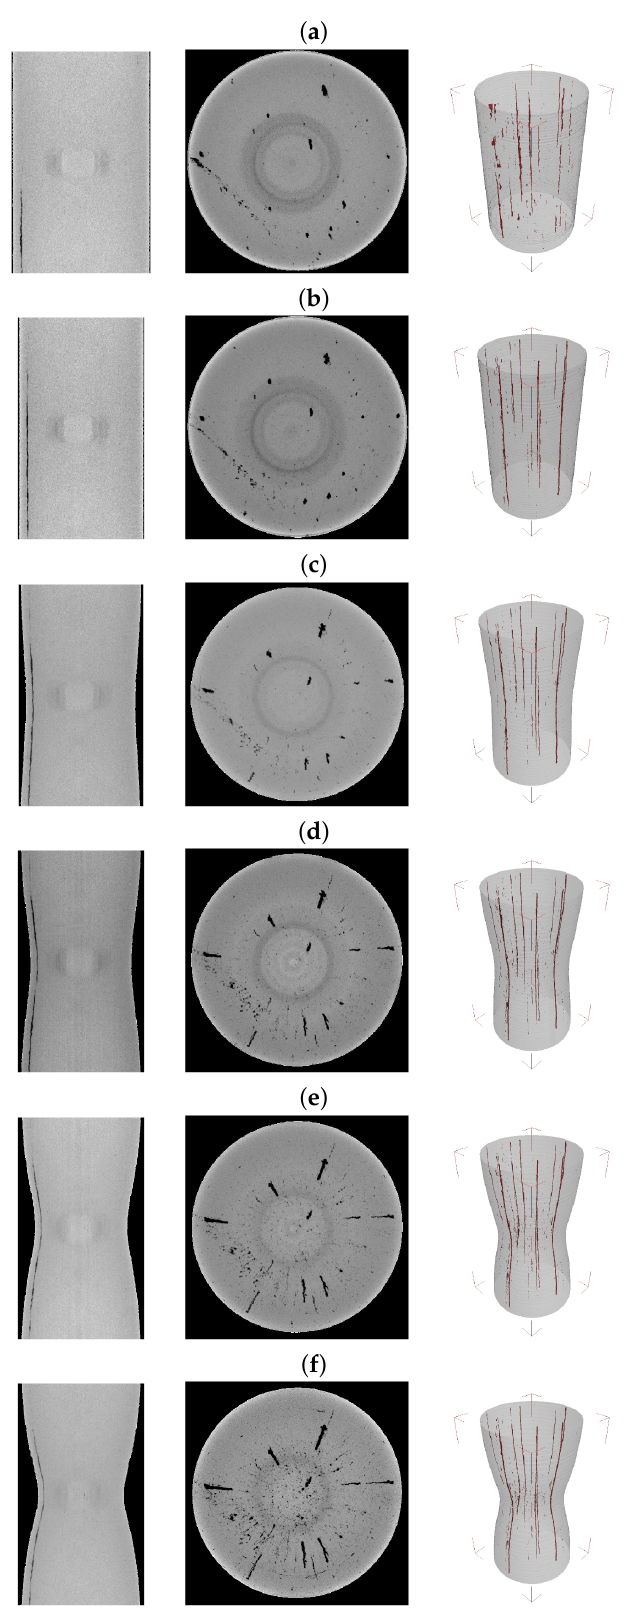
Figure 10. Results of the XRCT analysis of the necking zone for Material 2. For each step, three results are given: (I) Longitudinal section, (II) Damage projected on the cross section and (III) Perspective of the internal damage. ( a ) Step 0: Before testing ( ε eng = 0). ( b ) Step 1: Maximum load ( ε eng = 0.193). ( c ) Step 2 ( ε eng = 0.267). ( d ) Step 3 ( ε eng = 0.288). ( e ) Step 4 ( ε eng = 0.306). ( f ) Step 5 ( ε eng =